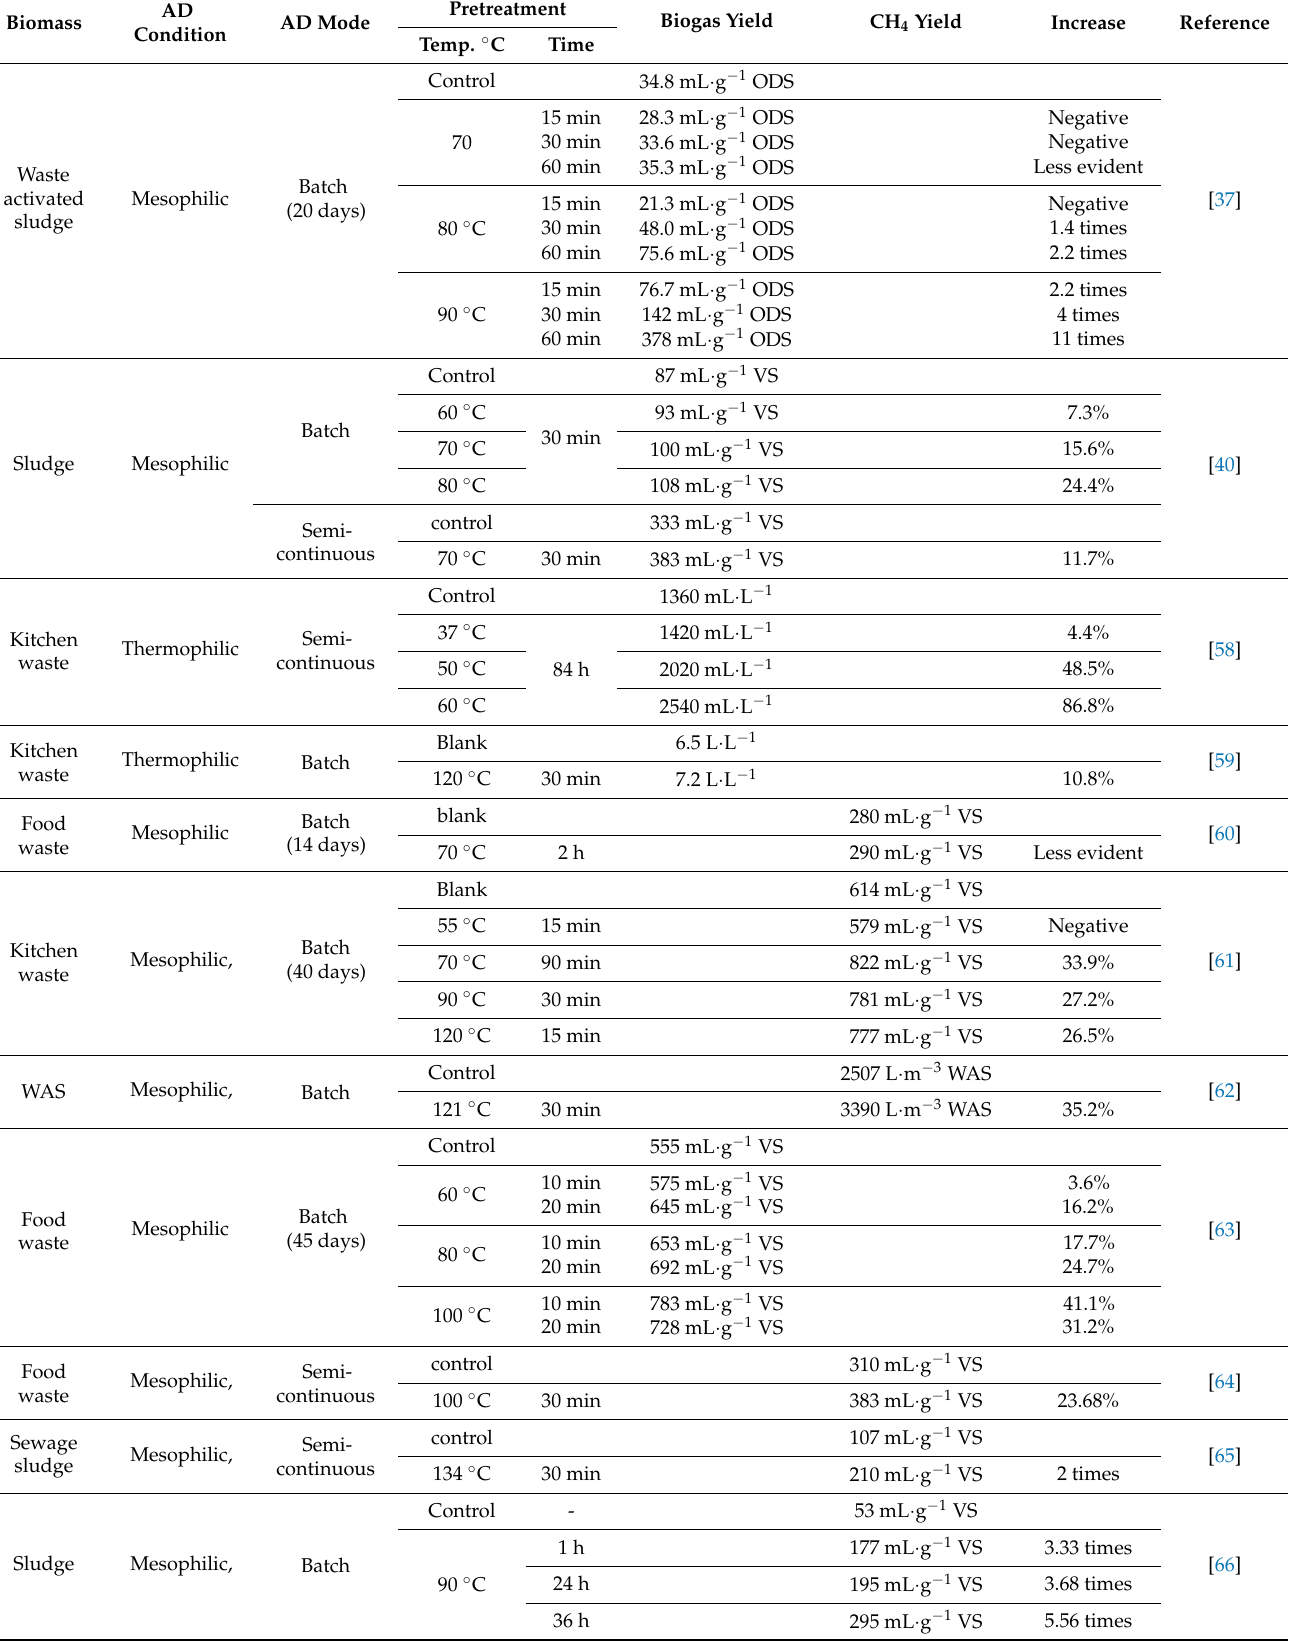
Table 1. Biogas production of OFMSW after LTPT (Temp. ≤ 140 ◦